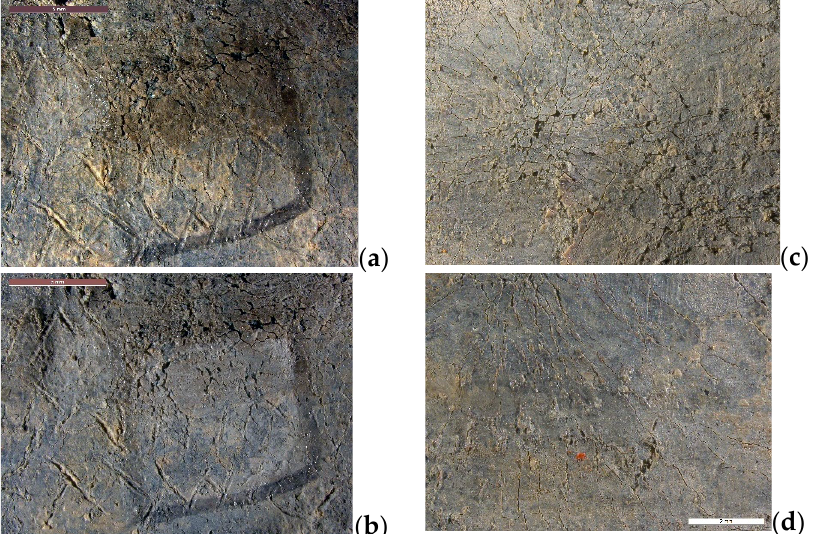
Figure 4. Results of gel treatments on curse tablet: before ( a ) and after application of agar with oxalic acid ( b ), before ( c ) and after application of xanthan with citric acid ( d ), (© L. Rossetti/Arc’Antique— Grand Patrimoine de Loire Atlantique, Nantes, France).